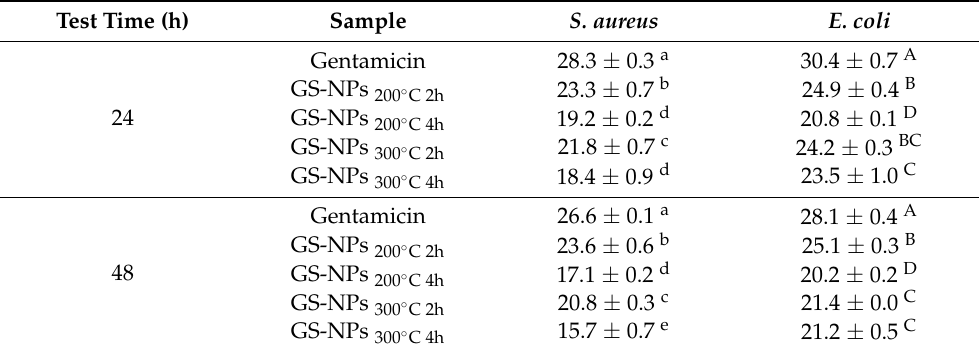
Table 3. The inhibition diameters produced by selected GS-NPs nanoparticles calcinated at tempera- tures (200 and 300 ◦ C) and times (2 and 4 h) against Staphylococcus aureus ( S. aureus ) and Escherichia coli ( E. coli ) over 48